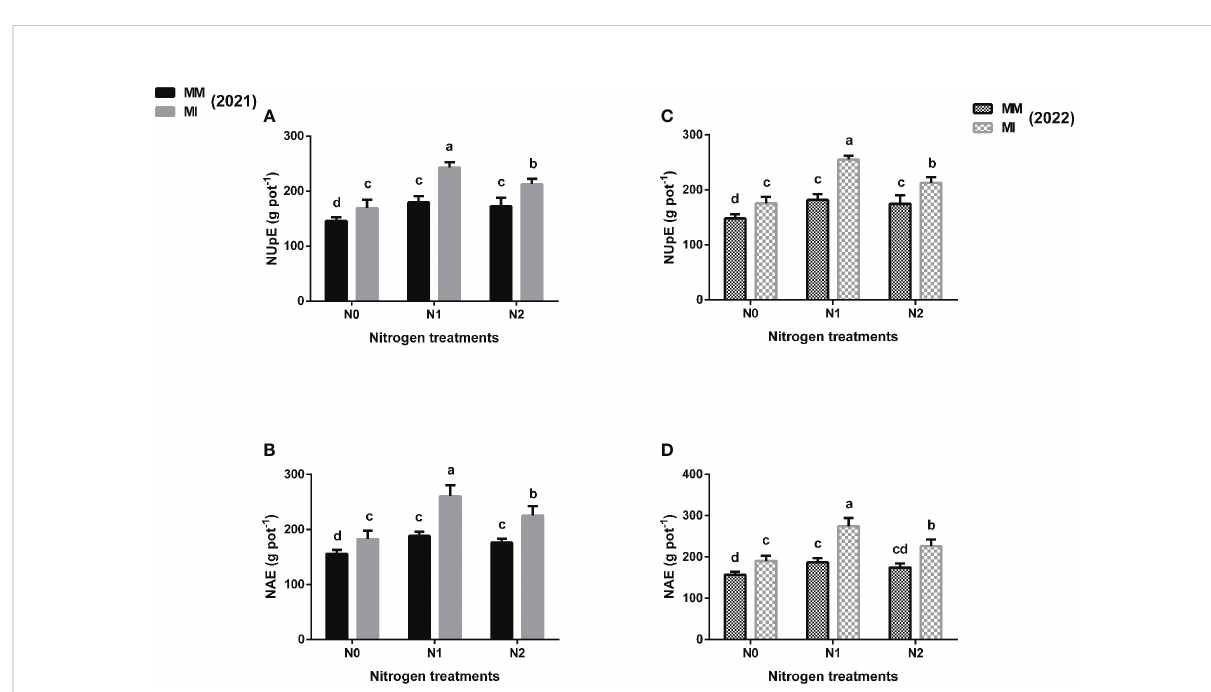
FIGURE 5 Maize nitrogen uptake ef fi ciency (NUpE) (A, C) , nitrogen agronomic ef fi ciency (NAE) (B, D) under different planting patterns (MM, maize mono- cropping and MI, maize intercropping) and N fertilizer application rates (N 0 ; 0 kg N ha -1 , N 1 ; 250 kg N ha -1 and N 2 ; 300 kg N ha -1 ) in 2021 and 2022 crop growing seasons. The column bars with dissimilar lowercase letters are signi fi cantly different from each other as per the LSD test ( p <